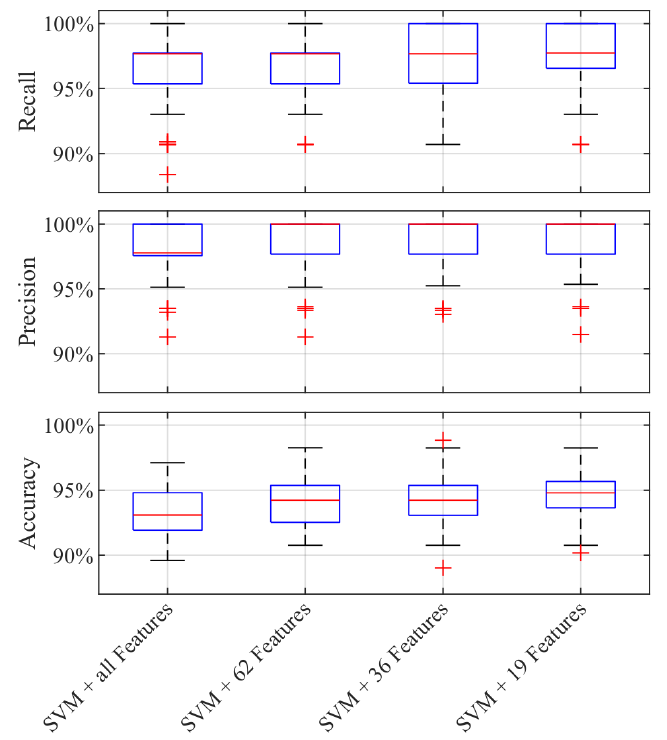
Figure 11. 10-by-10 cross-validation results of SVMs trained on different extracted feature